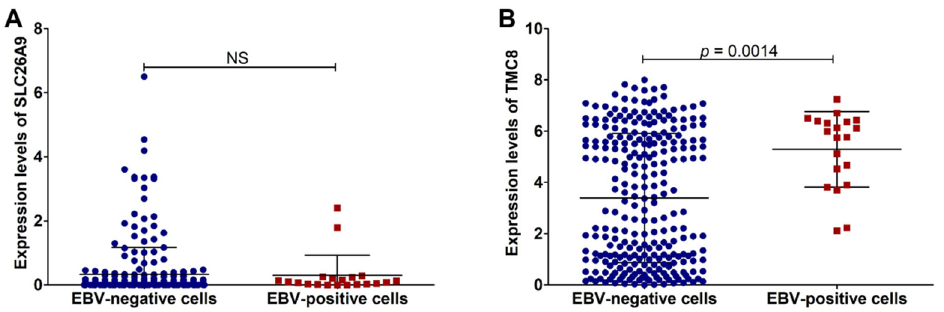
Figure 5. TMC8 is a potent signature gene for EBV ‐ associated malignancies. The expression of SLC26A9 ( A ) and TMC8 ( B ) in cancer cell lines using RNA sequencing dataset from the CCLE database.